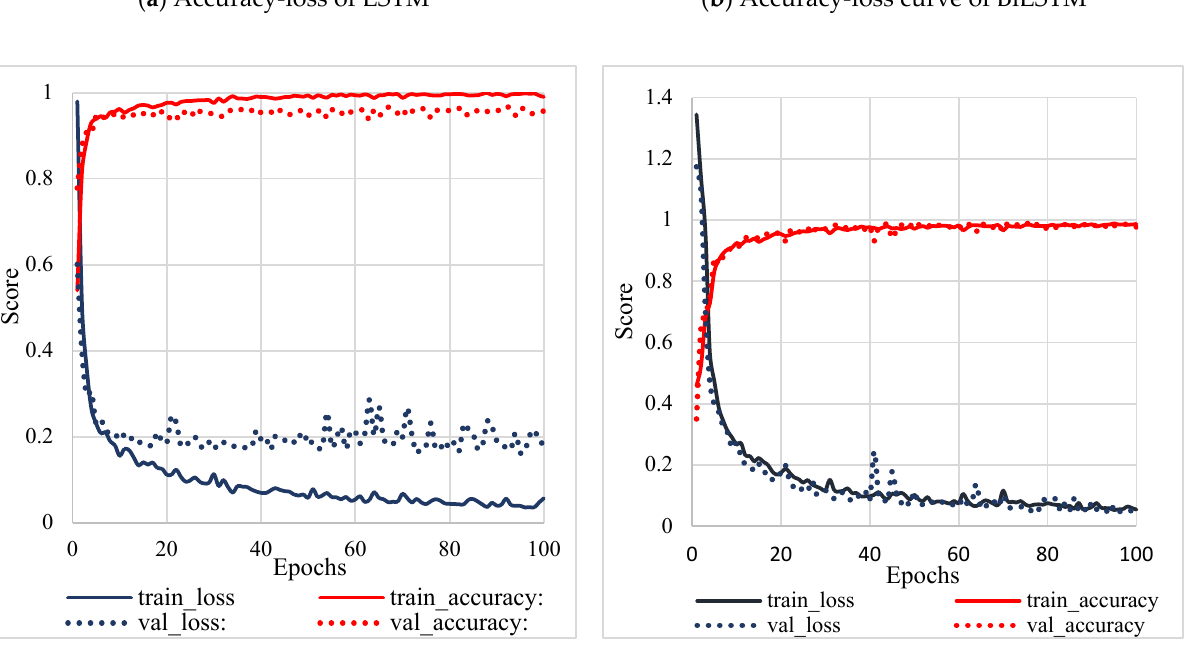
Figure 10. Model learning curves of LSTMs.